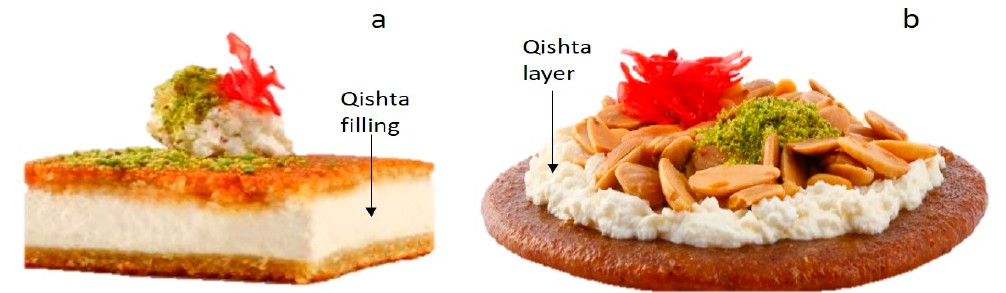
Figure 3. ( a ) Knefe, ( b ) Mafrouke prepared at Hallab 1881 company.